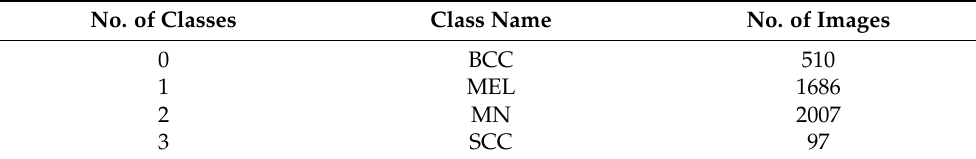
Table 3. Image samples of the Skin Cancer dataset are distributed after up-sampling.